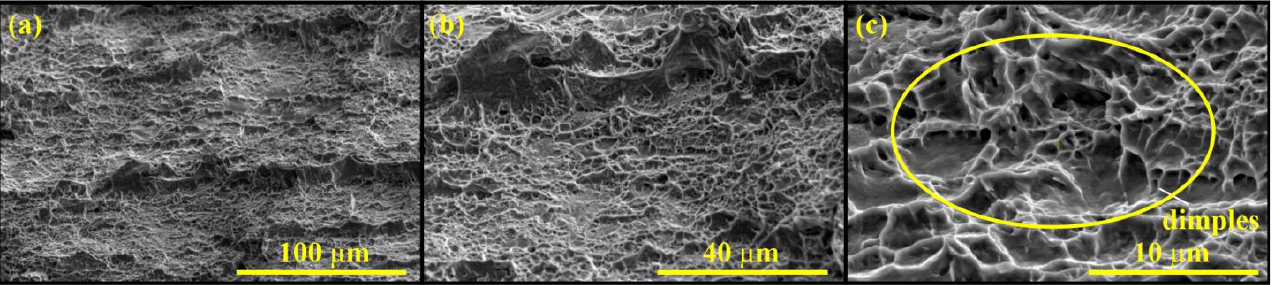
Figure 6. SEM/SE images of the fracture surface of Ti-4Al-3Mo-1V welded joint in heat-affected zone at different zoom levels ( a, b, c ).